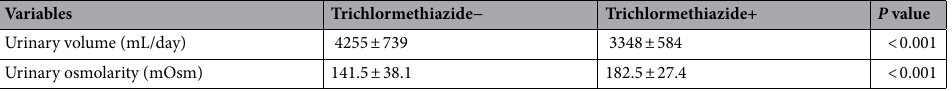
Table 2. Effect of trichlormethiazide on urinary volume and osmolarity. For these variables, the mean values at 4, 8, and 12 weeks of each trial were calculated.